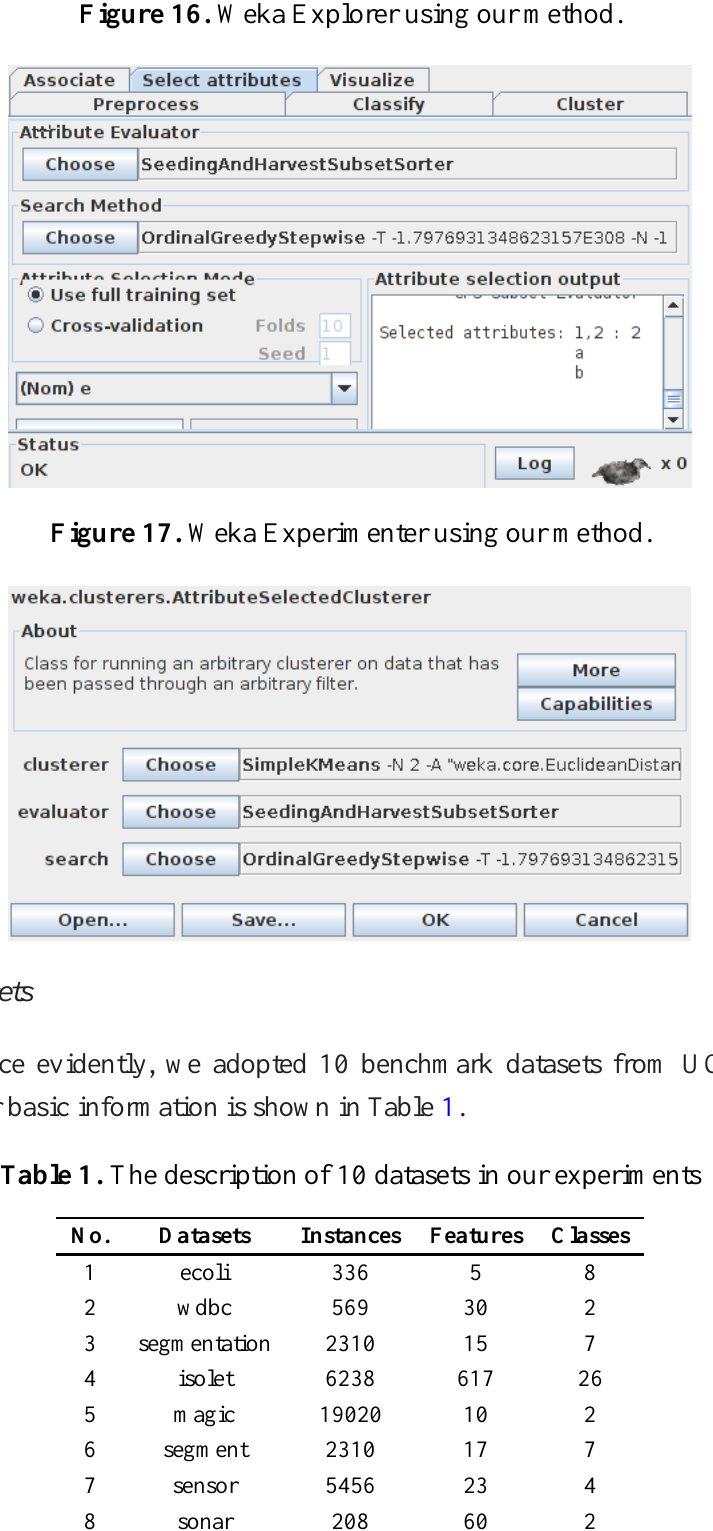
Figure 16. Weka Explorer using our method.